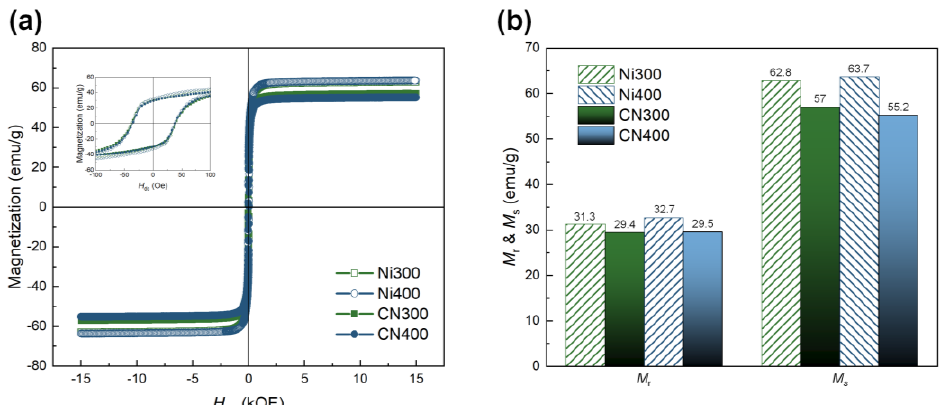
To identify the ferromagnetic properties, including M r and M s , of the CN laminates,